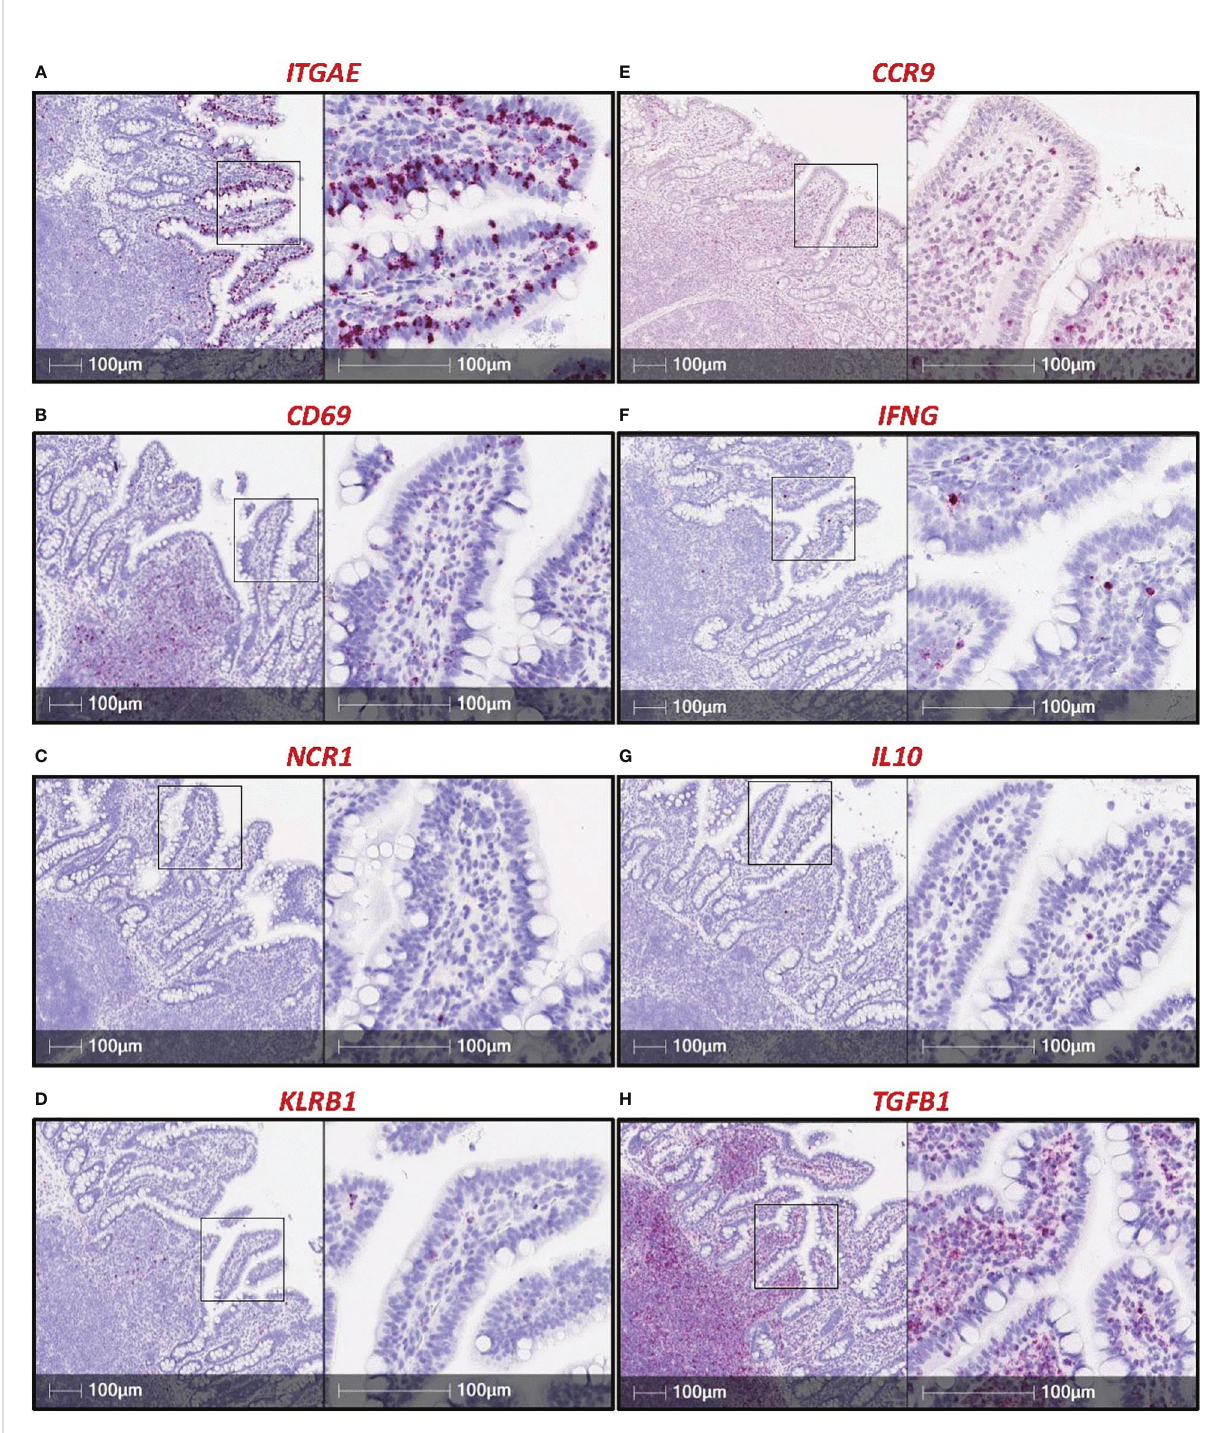
FIGURE 2 RNA-ISH staining of potential IEL markers in porcine ileum. Sections of ileum from a ~7.5-week-old pig stained for mRNA transcripts (red staining): ITGAE (A) , CD69 (B) , NCR1 (C) , CD161 (D) , CCR9 (E) , IFNG (F) , IL10 (G) , TGFB1 (H) . Probes were custom-designed from Advanced Cell Diagnostics with the following catalog numbers: ITGAE (#590611); CD69 (#590601); NCR1 (#553131); KLRB1 (#490871, product labeled CD161); CCR9 (#1062631); IFNG (#490821); IL10 (#442791); TGFB1 (#444951). A protocol for RNA-ISH staining is described previously (57). RNA-ISH (RNA in situ